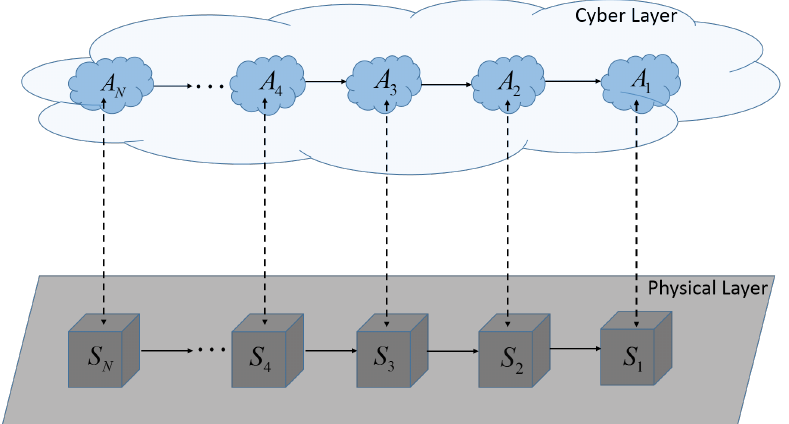
Figure 1. Schematic diagram of a cyber-physical multi-agent system